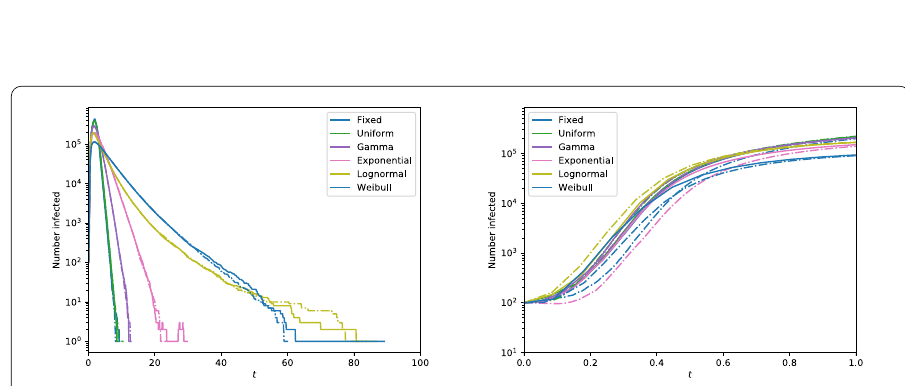
Figure 5 Epidemic sizes in a scalefree network. We look at epidemics in a truncated scale free network with 10 6 nodes having minimum degree 2 and maximum degree 954 and each degree k assigned with probability proportional to k –2 . This yields an average degree of approximately 10. Epidemics exist even at very small τ , and R p 0 is significantly larger than in the other networks. Using the heterogeneous R p 0 all curves collapse on a universal curve. The parameters, mean and variance of the distributions are given in Table 1